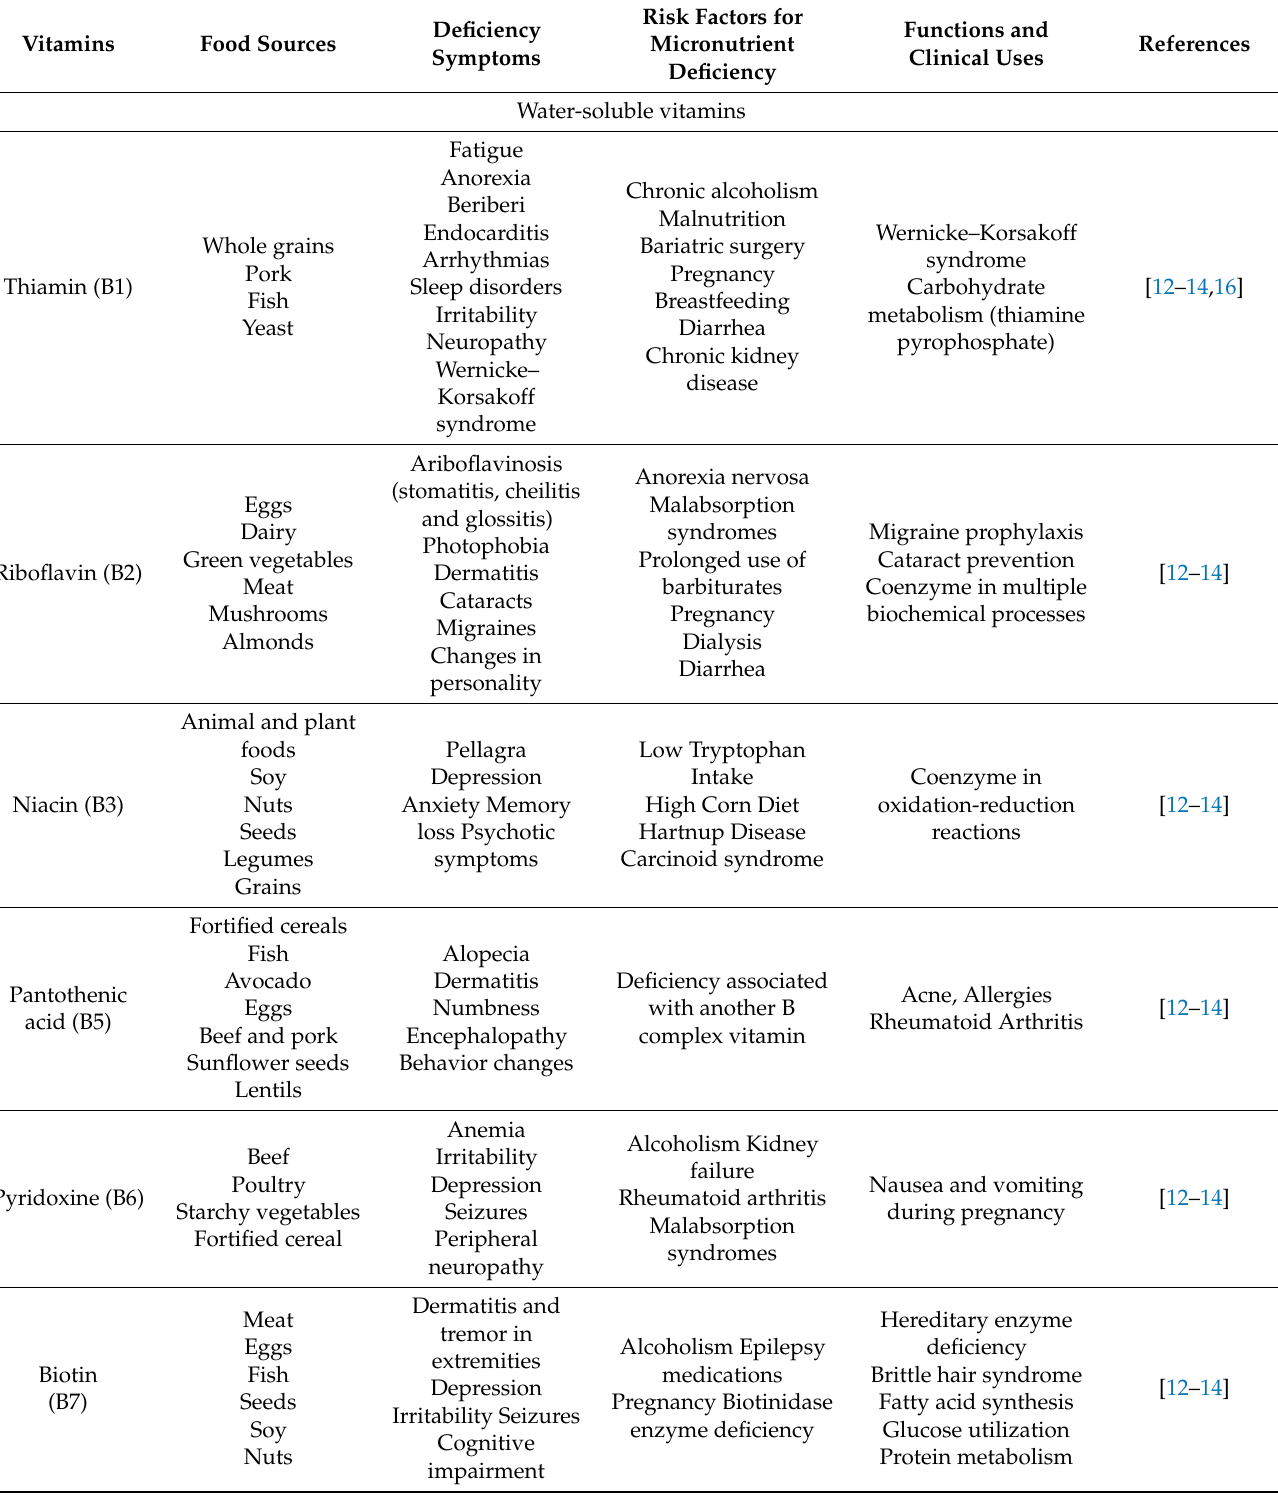
Table 1. Function and clinical uses of